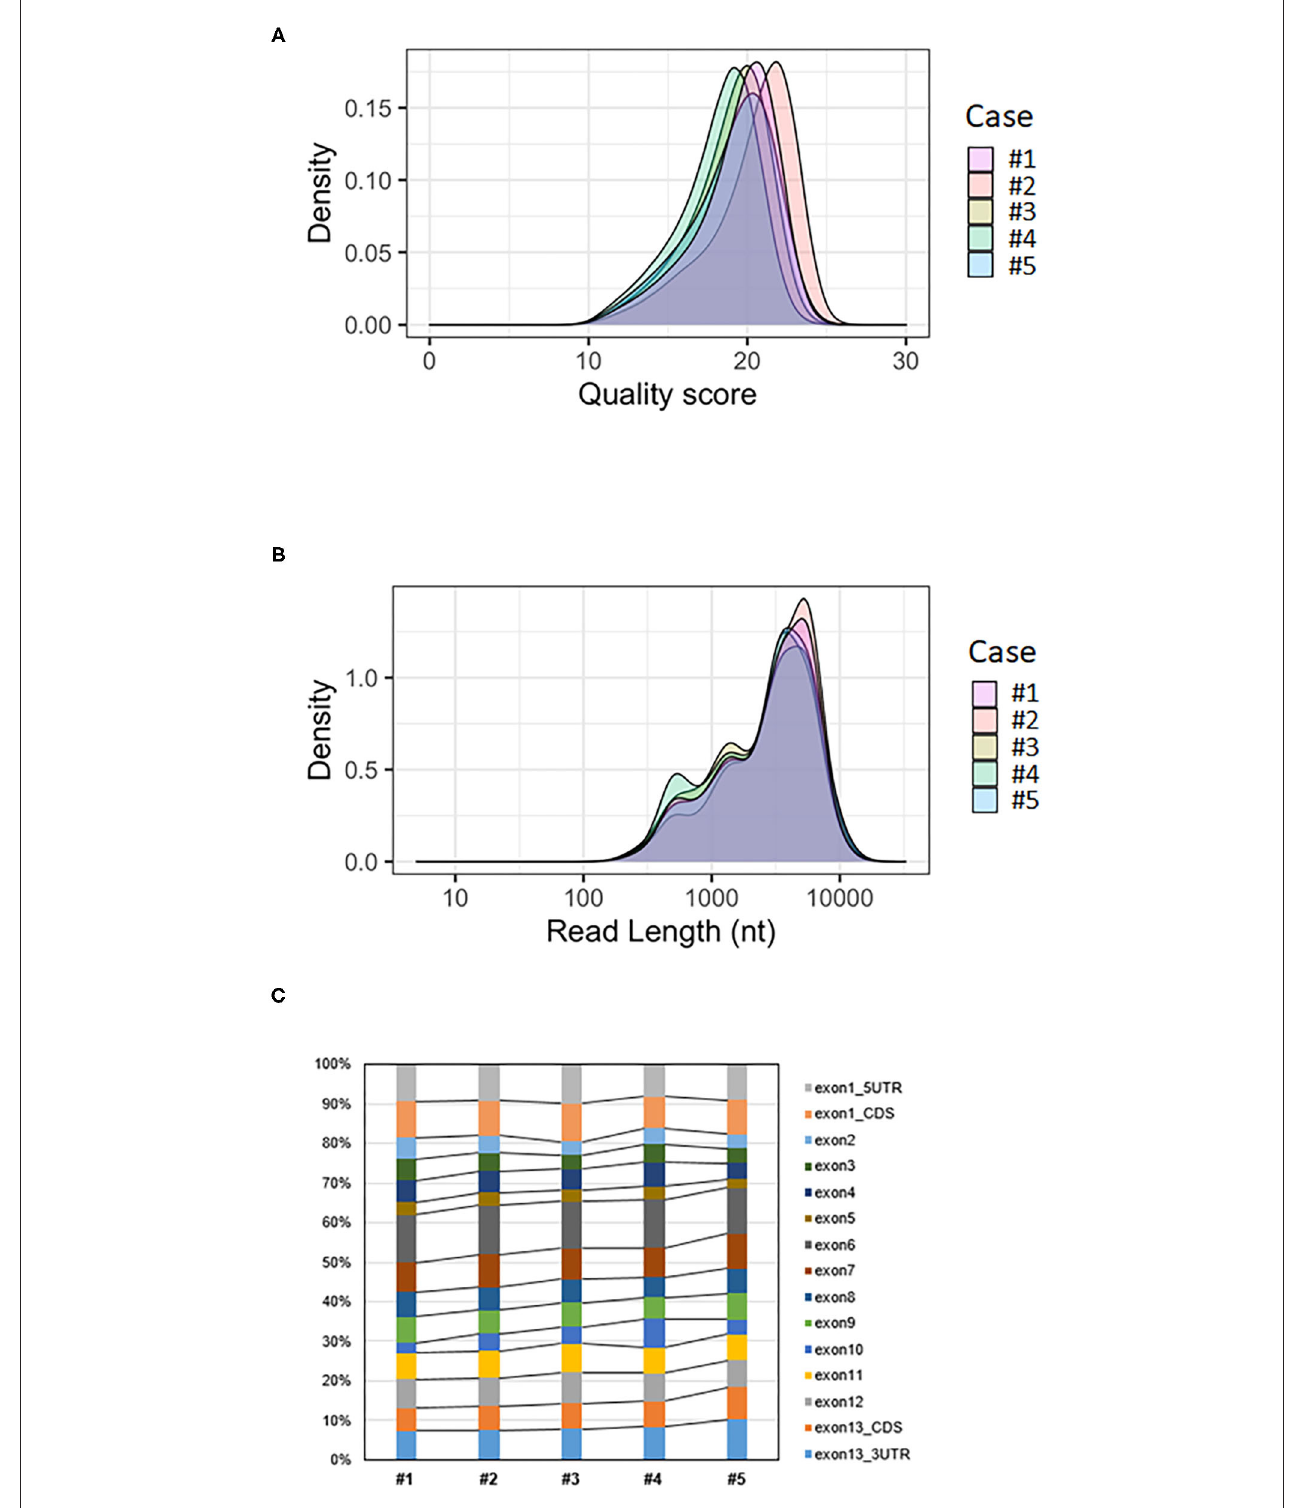
FIGURE 2 | Analysis of BMPR2 targeted MinION sequencing data. (A) Quality score distribution of reads. (B) Read length distribution of reads; the X-axis is log10 transformed; nt = nucleotides. (C) Ratio of aligned reads per exon.